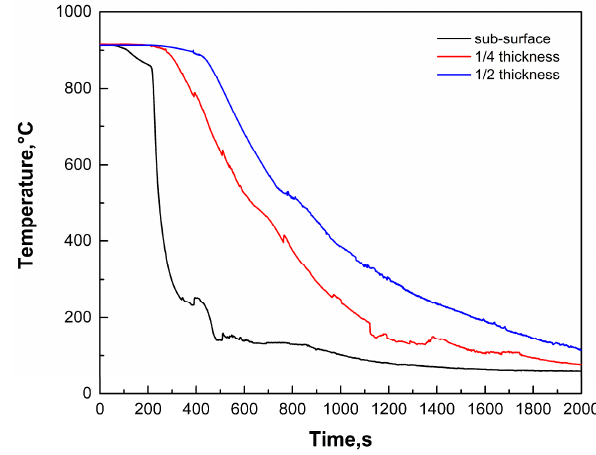
Figure 12. Measured industrial quenching temperature curves of the 178 mm thick steel plate.